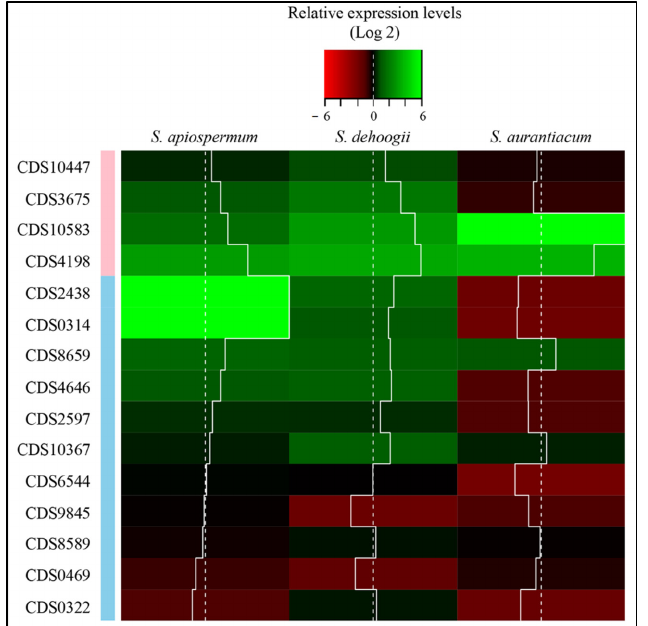
Figure 4. Relative expression level (Log2) of candidate genes in the presence of lignin. For each species, results correspond to the average of RT-qPCR analysis performed on three different isolates. Pink: peroxidases; blue: oxidases. CDS: coding sequence.